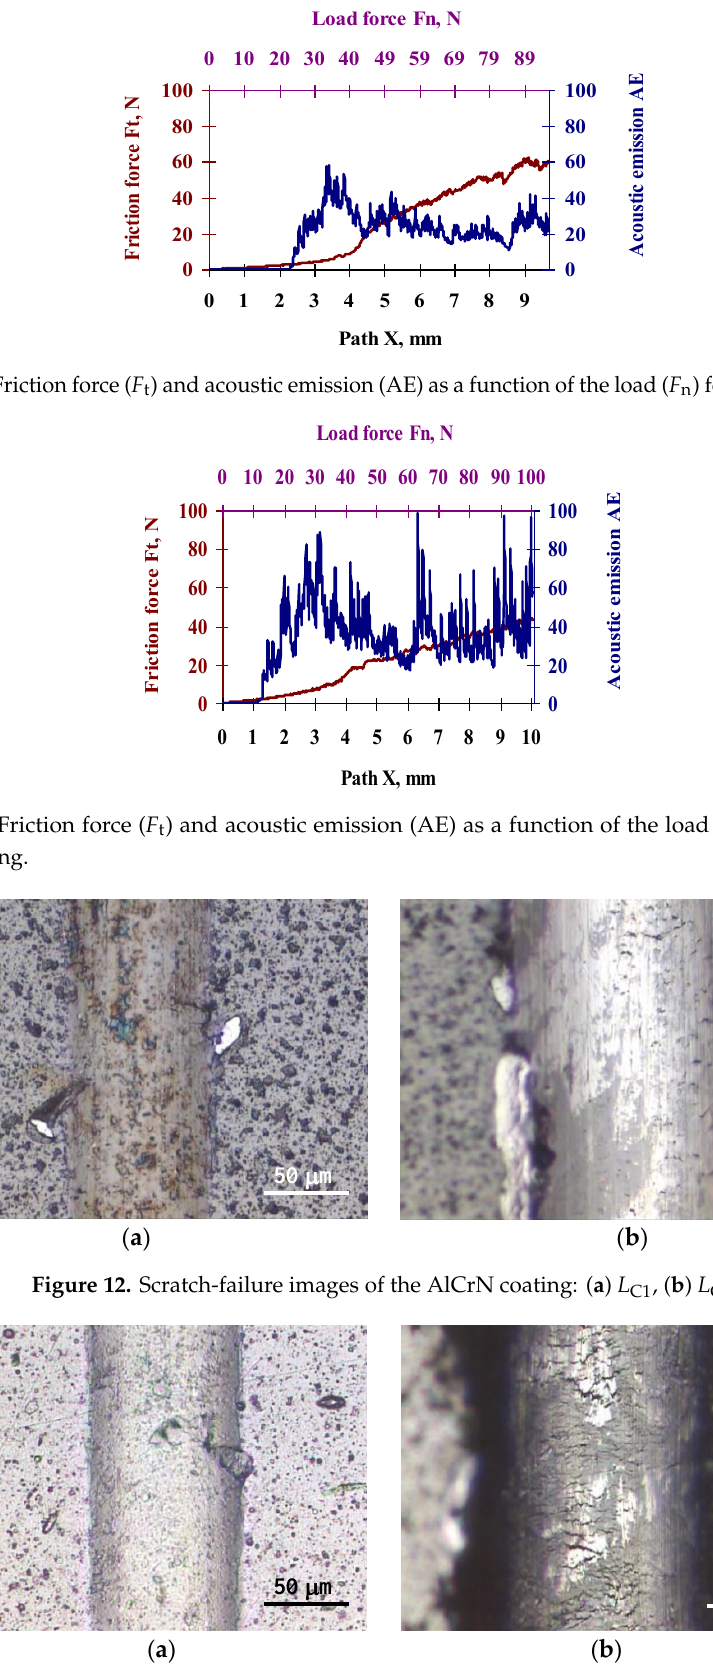
( e ) Figure 9. Structure of the CrCN layer: ( a ) TEM-BF image; ( b ) TEM-DF image based on the reflex (11- 1); ( c ) HRTEM micrograph; ( d ) electron diffraction pattern; ( e ) result of the chemical composition analysis.